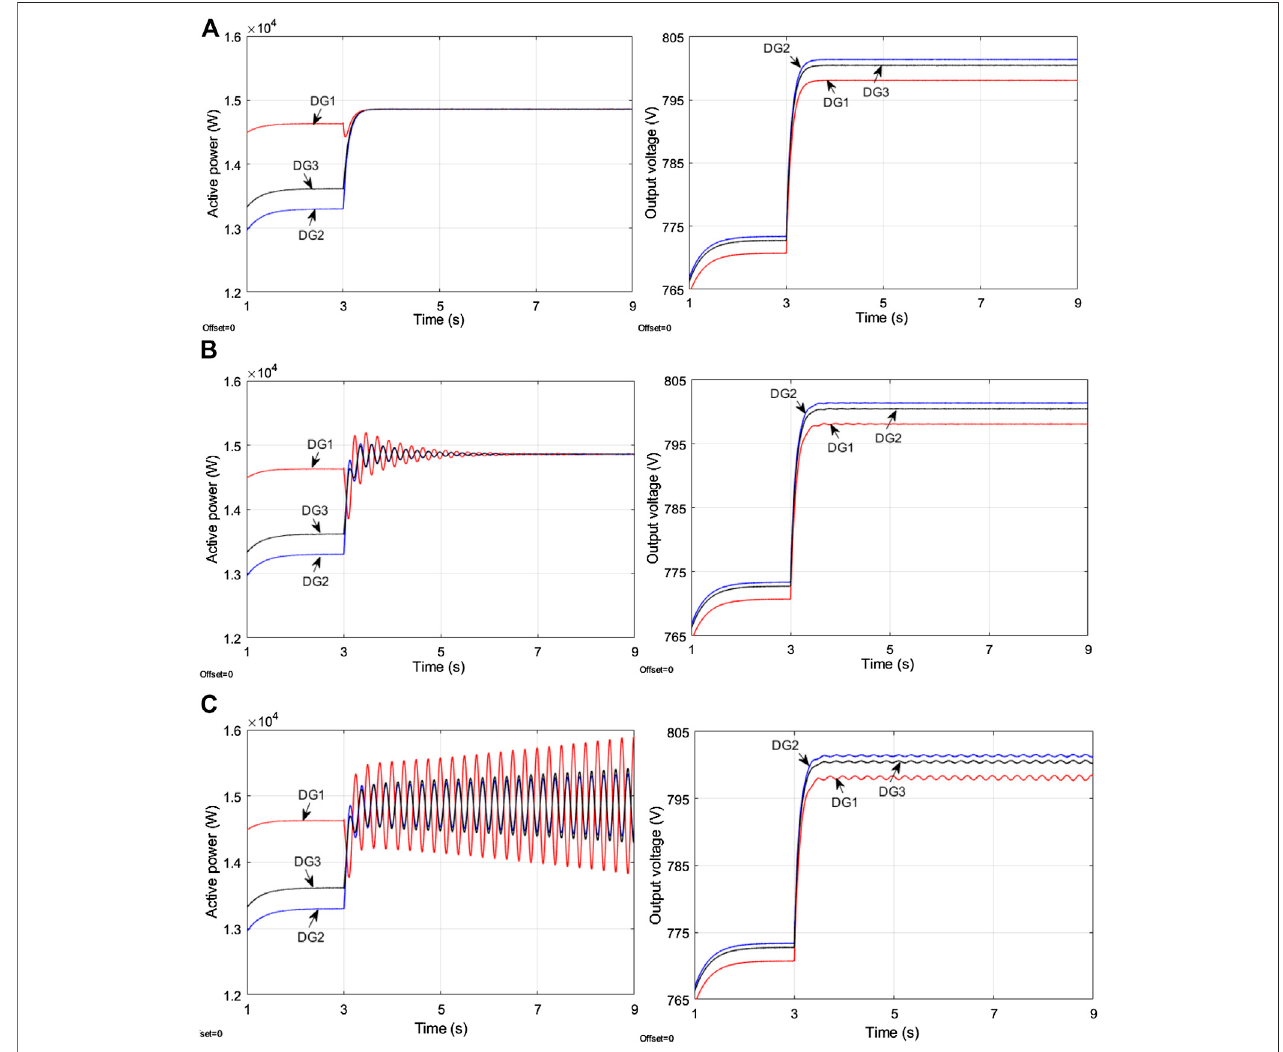
FIGURE 8 | Simulation results of active powers and actual output voltages with various time delays under k i 1 (cid:1) 12, k i 2 (cid:1) 10 (A) Without delay (B) τ (cid:1) 83 ms (C) τ (cid:1) 98 ms.